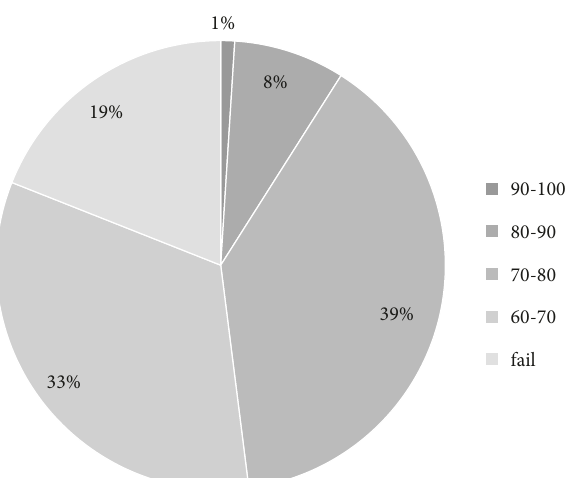
Figure 2: Distribution of male endurance scores in 2019.